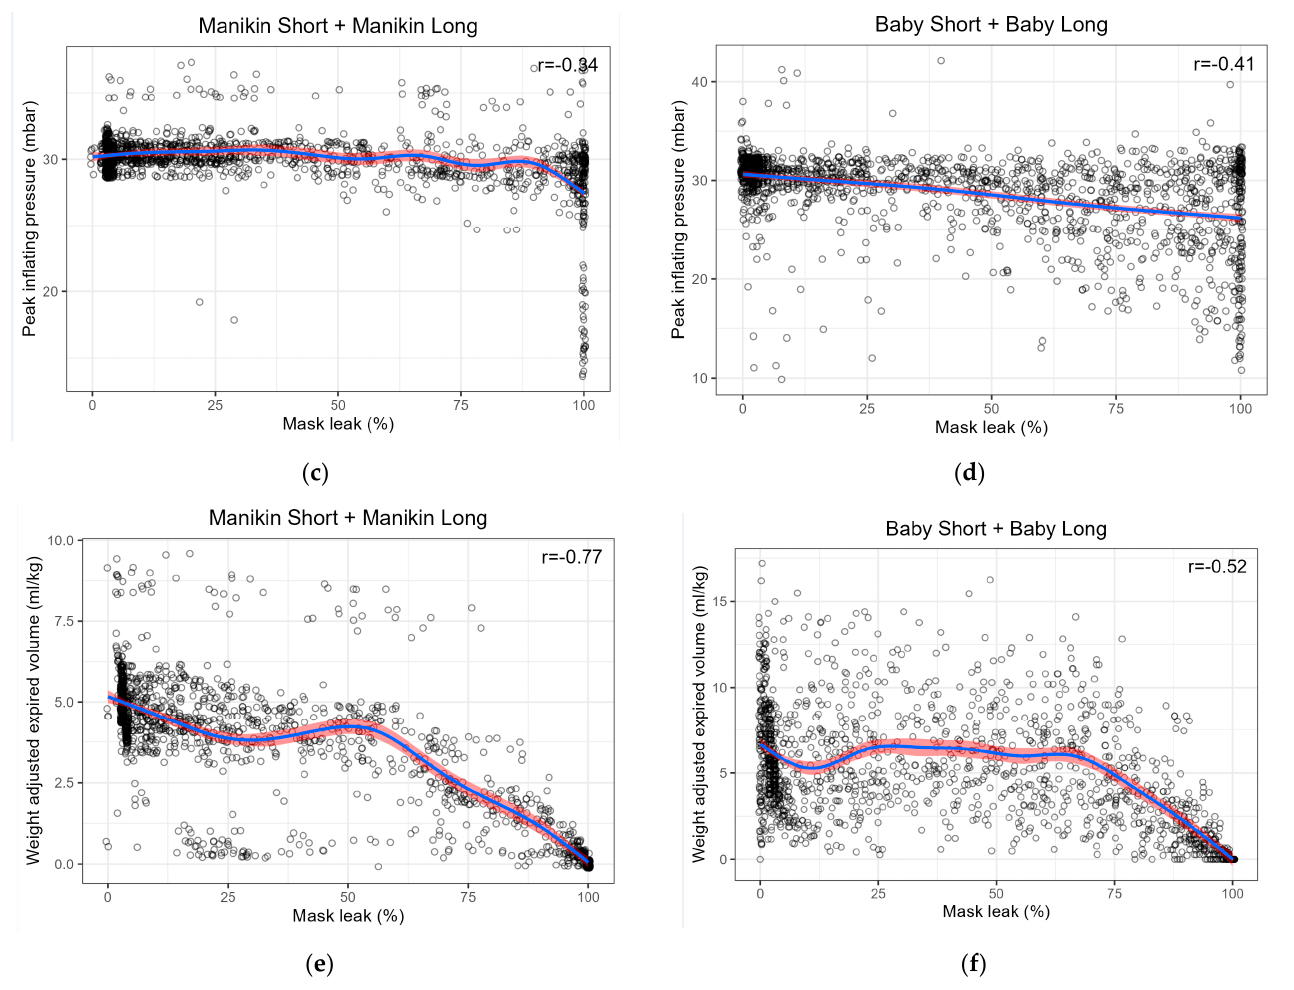
Figure 4. Scatter plots of correlation between ( a ) Peak inflating pressure (PIP) and expired tidal volume (eV T) for combined